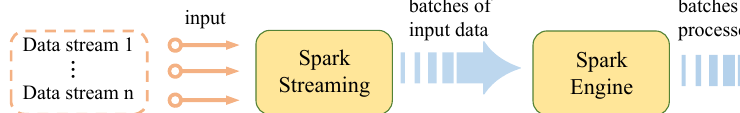
Figure 1. Flowchart of Spark Streaming.